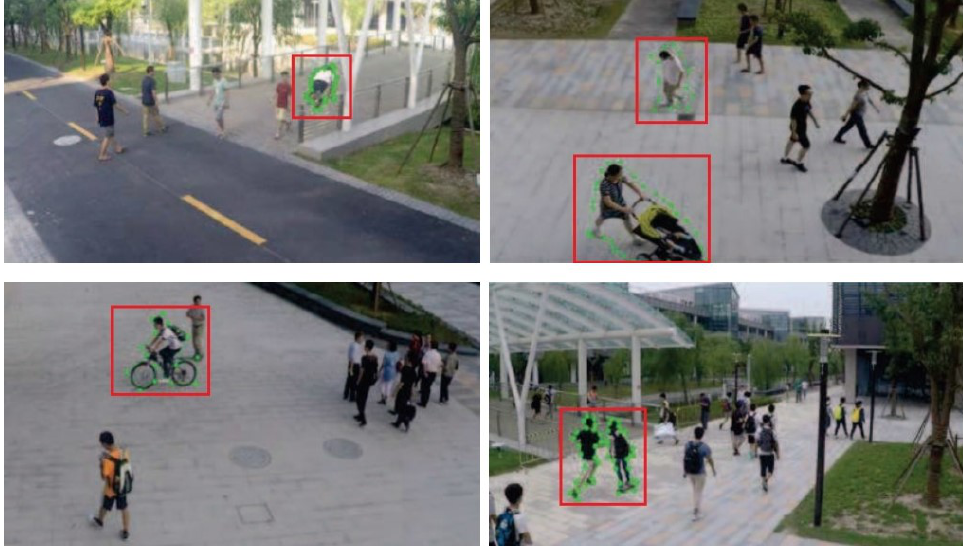
Figure 6. Examples of abnormal frames from the ShanghaiTech